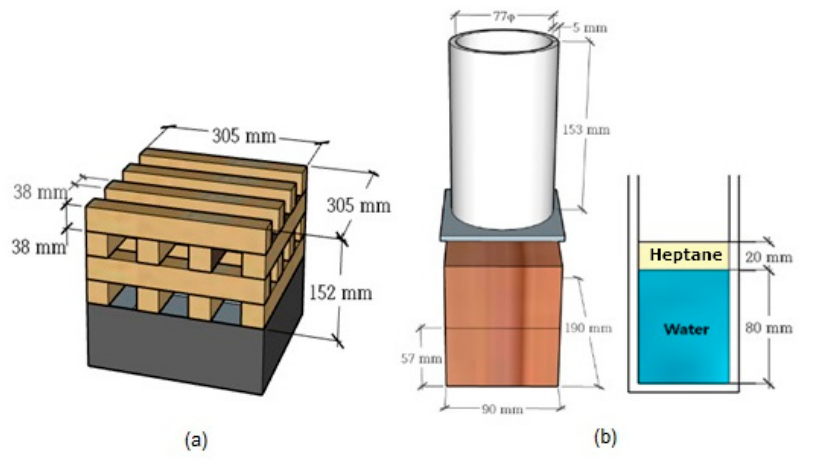
Figure 3. ( a ) Wood crib and ( b ) heptane can used in fire testing. A cone calorimeter (ISO 5660) was used to measure the HRRPUA of the combustibles used for fire testing. We measured the HRRPUA of the PUF and wood cribs used in sofa models, as shown in Figure 4. The HRRPUA of the PUF used in the sofa model was 559.75 kW/m 2 . This is relatively consistent with the HRRPUA of over 550 kW/m 2 as specified in Section